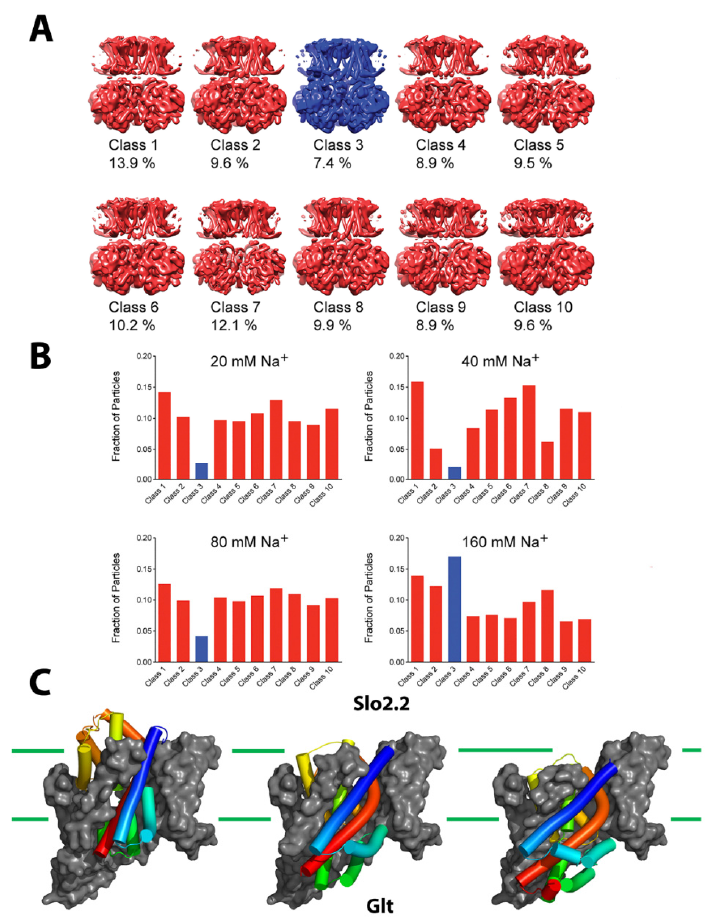
Figure 2. ( A ) 3D class averages from a combined dataset of Slo2.2 vitrified in the presence of 20 mM, 40 mM, 80 mM, and 160 mM Na + concentrations. Classes that resemble closed Slo2.2 are colored red and open colored blue. ( B ) A fraction of particles in each class is shown for the 20–160 mM Na + concentrations. Reproduced with permission from Elsevier. ( C ) Structures illustrate a twisting elevator movement to effect substrate traversal across the bilayer. Transport domain is depicted as colored cylinders and scaffold domain as dark grey surface. For clarity, only one protomer of the obligate homotrimer is shown. Models were resolved by X-ray crystallography, cryo-EM, and aided by engineered disulfide trapping. Left panel: outward-open Glt Ph (PDB 2NWW); middle panel: intermediate, putative Cl − conducting state of Glt Ph (PDB 6WYK); right panel: inward-open (TBOA-inhibited) state of Glt Tk (PDB